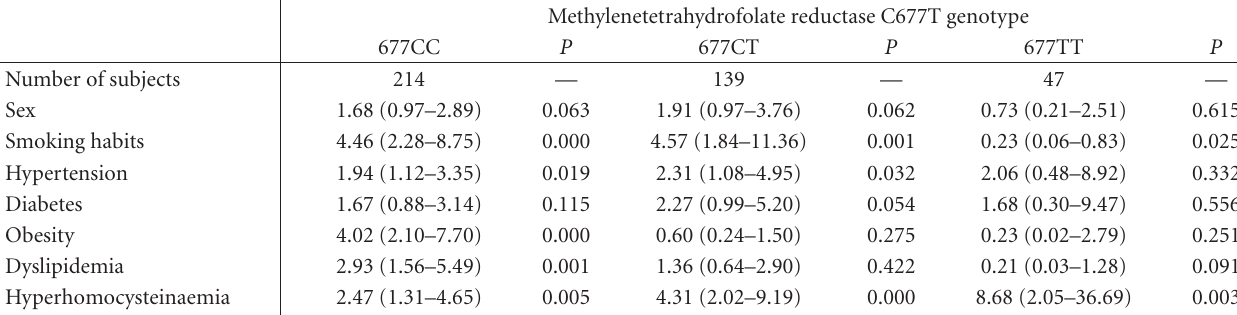
Table 5: OR (95% CI) of CAD associated to the studied risk factors according to MTHFR C677T polymorphism. OR: odds ratio; 95% CI: 95% confidence interval; CAD: coronary artery disease; MTHFR: methylenetetrahydrofolate reductase; P : significant